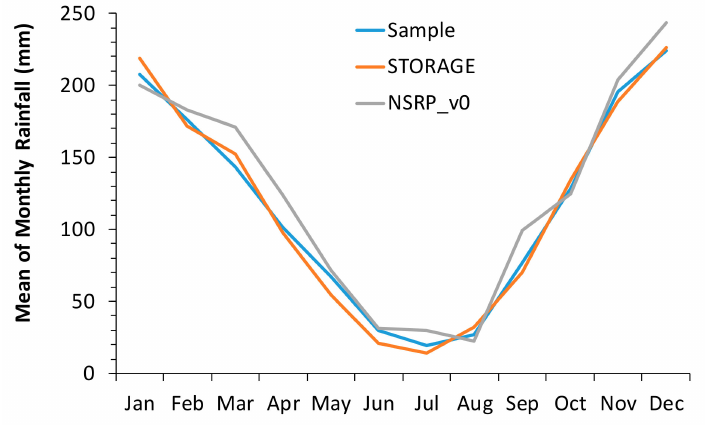
Figure 24. Montalto Uffugo rain gauge: comparison between STORAGE and NSRP_v0 performances, focusing on mean values of monthly rainfall heights.